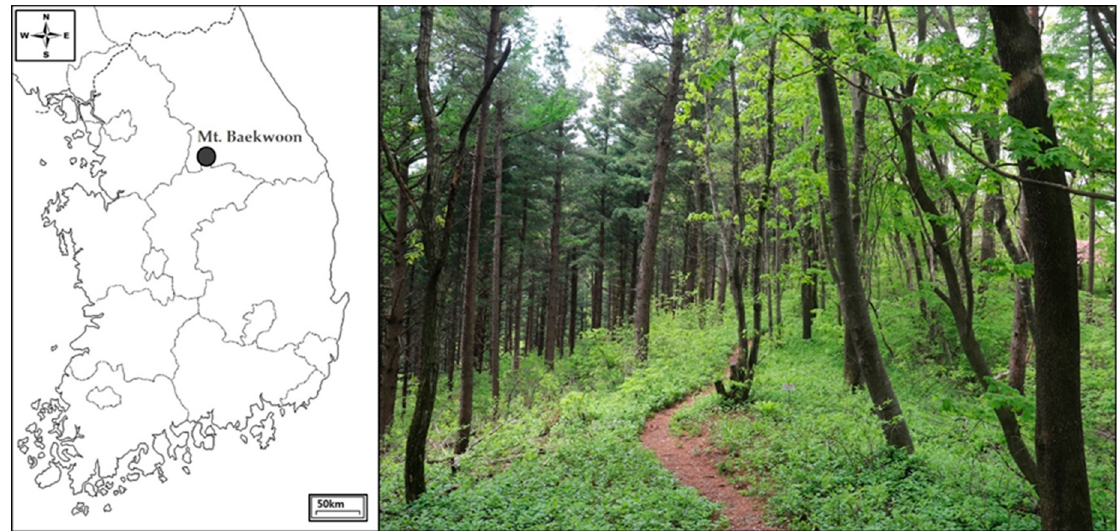
Figure 1. Location of Mt. Baekwoon in Gangwon Province, South Korea (37°15 ′ 43.90 ″ N, 127°56 ′ 20.72 ″ E).